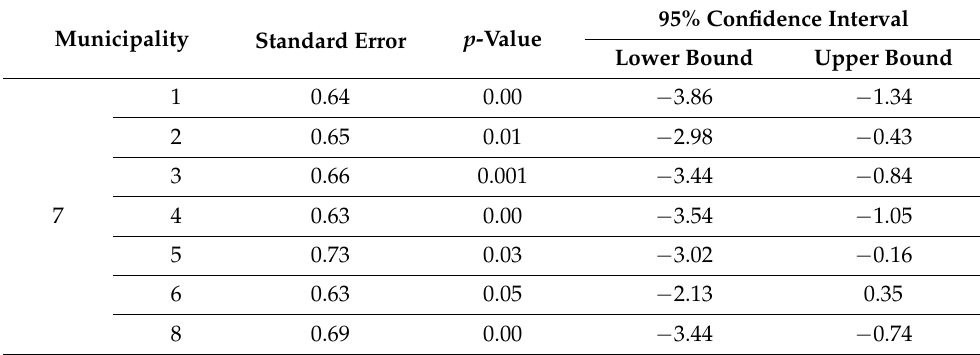
Table 5. Results of ANOVA (LSD) about the differences between group means of district 7 with other municipality districts in terms of awareness and